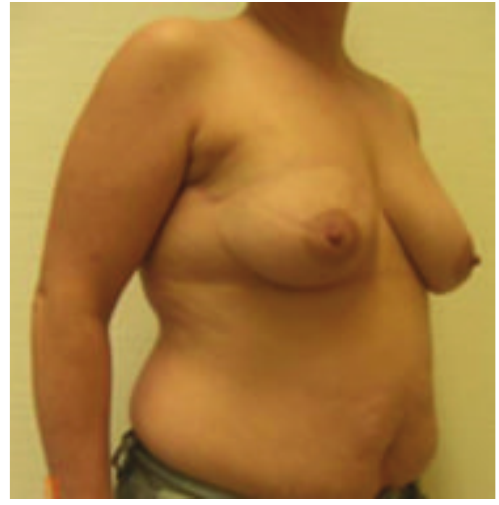
Figure 6: Same patient at 19-month follow-up, oblique view.